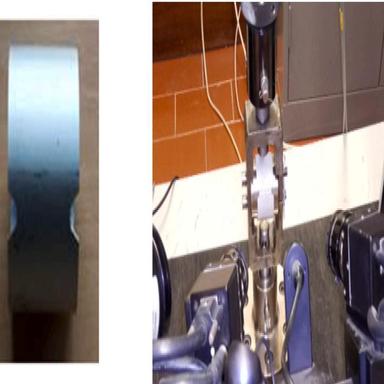
(a) RHPST specimen; (b) tensile loading fixture of the RHPST with DIC monitoring of the strain field.